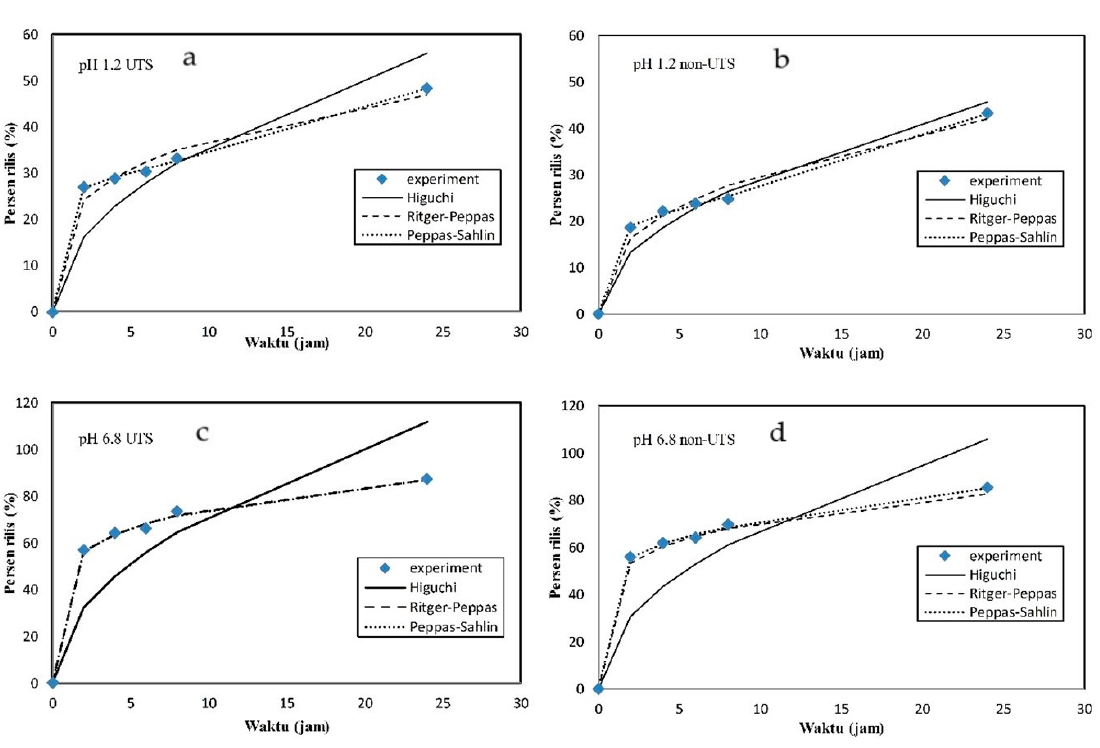
Figure 6. Release kinetic plots: ( a ) pH 1.2 non-UTS; ( b ) pH 1.2 UTS; ( c ) pH 6.8 non-UTS; ( d ) pH 6.8 UTS. Table 3. Encapsulation efficiency and particle